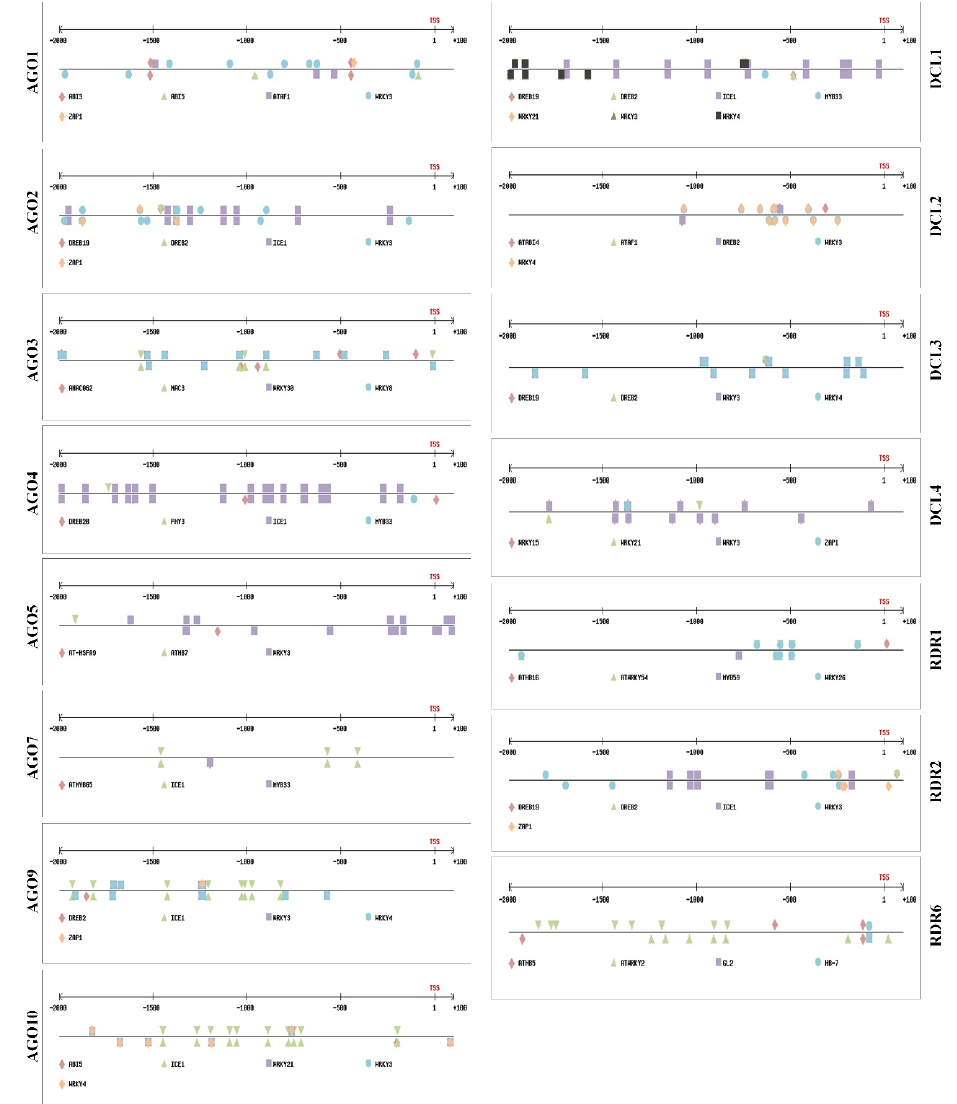
Figure 1. Transcription factor (TF) binding sites of ABA- and SA-related TFs in the promoters of RNA silencing genes: Binding sites of ABA- and SA-regulated TFs on the promoters of RNA silencing genes ( AGO , DCL , and RDR gene families). Promoter regions 2000 bp upstream of the transcription start site (TSS) were subjected to promoter analyses using the Plant Promoter Analysis Navigator in PlantPan 2.0. The TFs and their binding sites ( cis -regulatory elements ) were visualized using PlantPan 2.0.